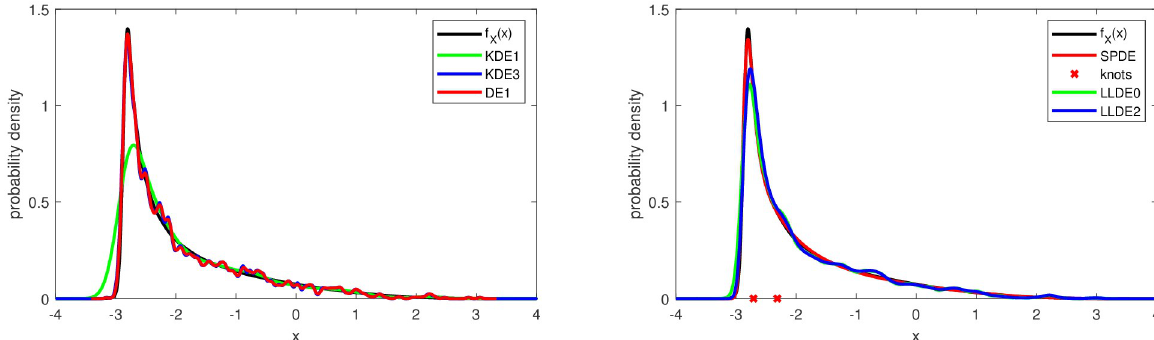
Fig 1. Test case 2: Example of density estimates obtained from the kernel density and diffusion estimators (left) as well as from the semiparametric and local likelihood estimators (right). The SPDE is the model SPL2 with 2 knots after knot deletion. The sample size is N = 2000.